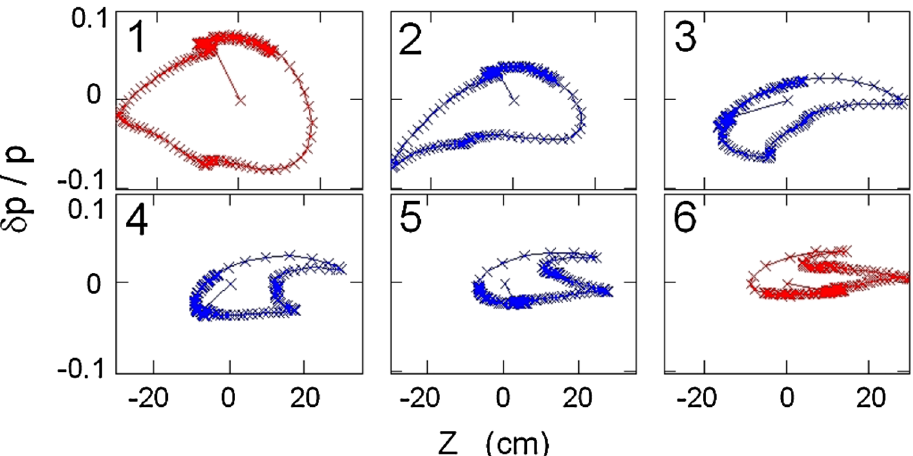
FIG. 13. (Color) Longitudinal beam size evolution through the accelerator complex at (1) recirculator entrance, (2) arc 1 exit, (3) arc 2 exit, (4) arc 3 exit, (5) arc 4 exit, and (6) recirculator exit. In each graph particle positions in ( z - (cid:5)p=p ) of the longitudinal beam envelope are displayed.